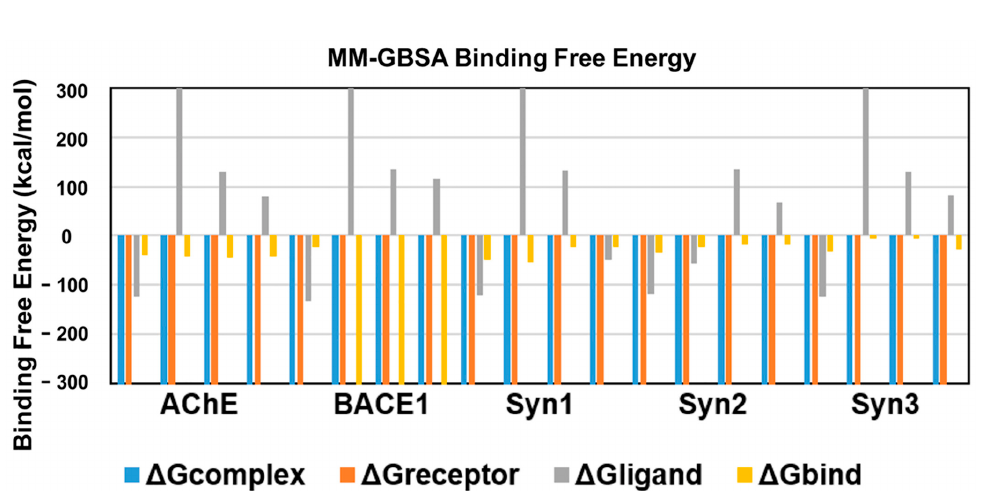
Figure 6. Binding free energies of bioactive compounds of R. officinalis against AChE, BACE1, synapsin I, synapsin II, and synapsin III with CA, RA, UA and donepezil, respectively. BACE1 exhibited the lowest binding free energy ( ∆ G bind ) values and showed the most stable complexes against all ligands. UA with a ∆ G bind value of − 2610.6